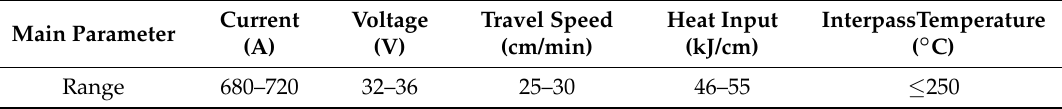
Table 2. Welding conditions to produce the welded joint [18].